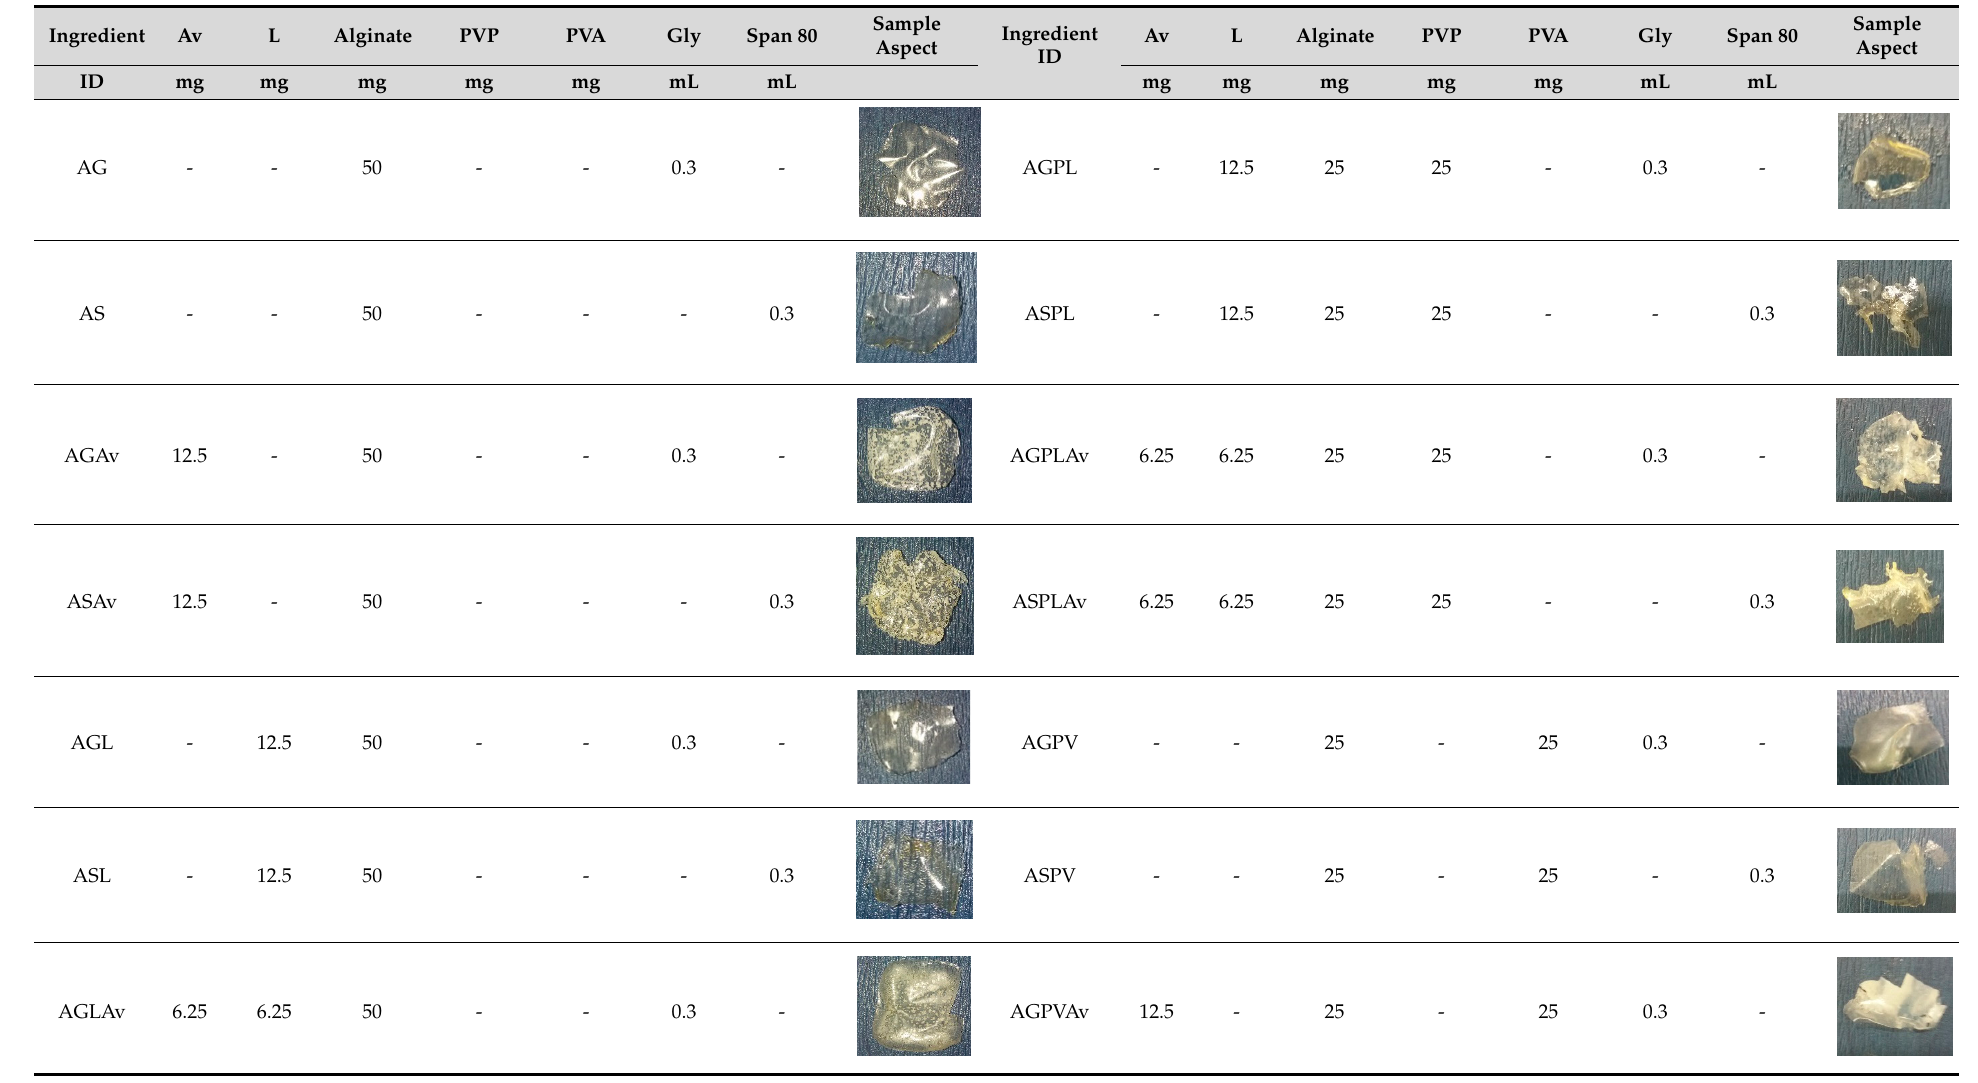
Table 1. Patches formulation. Table 1 . Patches formulation. Table 1 . Patches formulation. Table 1 . Patches formulation. Table 1 . Patches formulation. Table 1 . Patches formulation.